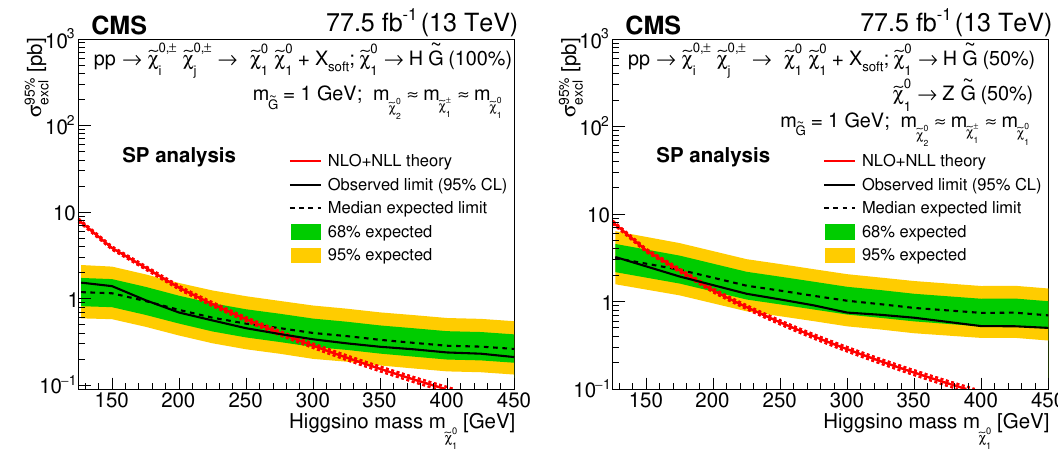
Figure 7 . The observed 95% CL upper limits on the production cross section for higgsino-like chargino-neutralino production are shown for the SP analysis. The charginos and neutralinos un- dergo several cascade decays producing either Higgs bosons (left plot), or a Higgs boson and a Z boson (right plot). We present limits in the scenario where the branching fraction of is 100% (left plot), and where the dotted and solid black curves represent the expected and observed exclusion region, and the green dark and yellow light bands represent the (cid:6) 1 and (cid:6) 2 standard deviation regions, respectively. The red solid and dotted lines show the theoretical production cross section and its uncertainty